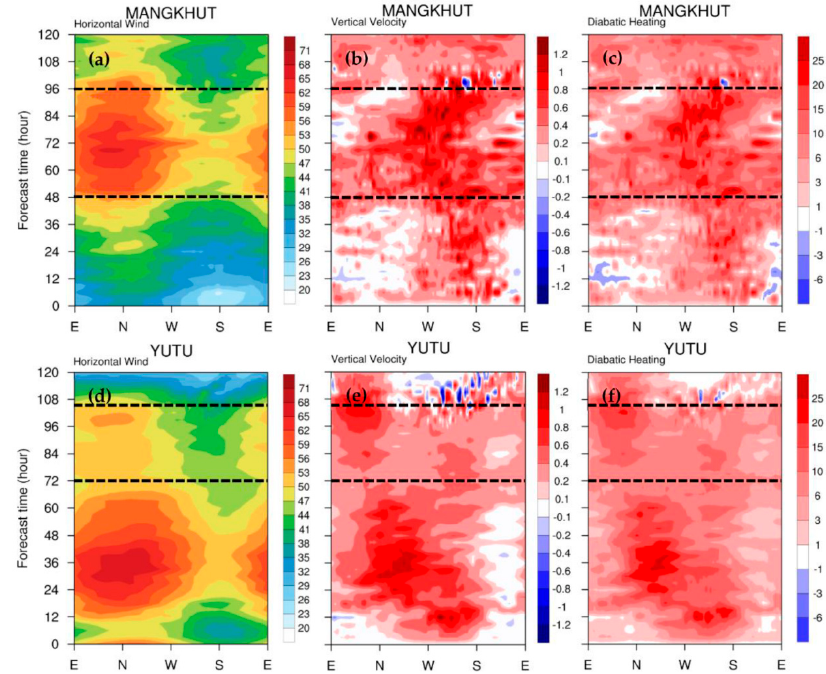
Figure 11. Hovmöller plots of ( a ) horizontal wind speed (in m s − 1 ), ( b ) vertical velocity (in m s − 1 ), and ( c ) diabatic heating (in W h − 1 ) averaged in 1–8 km height and radii of 0.5°–1.5° with respect to azimuth for Mangkhut. ( d – f ) Same as in ( a – c ), respectively, but for Yutu. The two black dashed lines indicate the time period of track deflection and landfall.